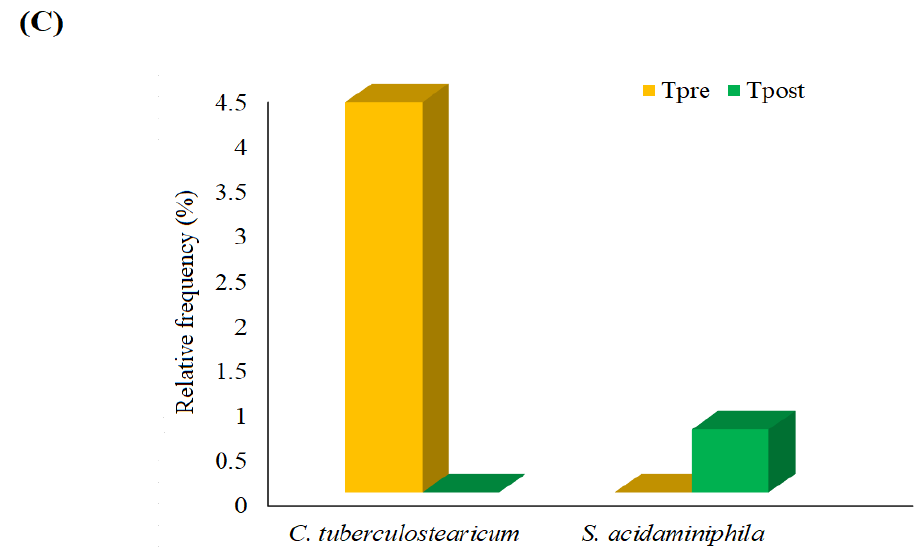
Figure 4. The graph shows the detected phylum ( A ), genus ( B ), and species ( C ) in the treatment group. * Statistically significant changes in the abundance of the respective genus.